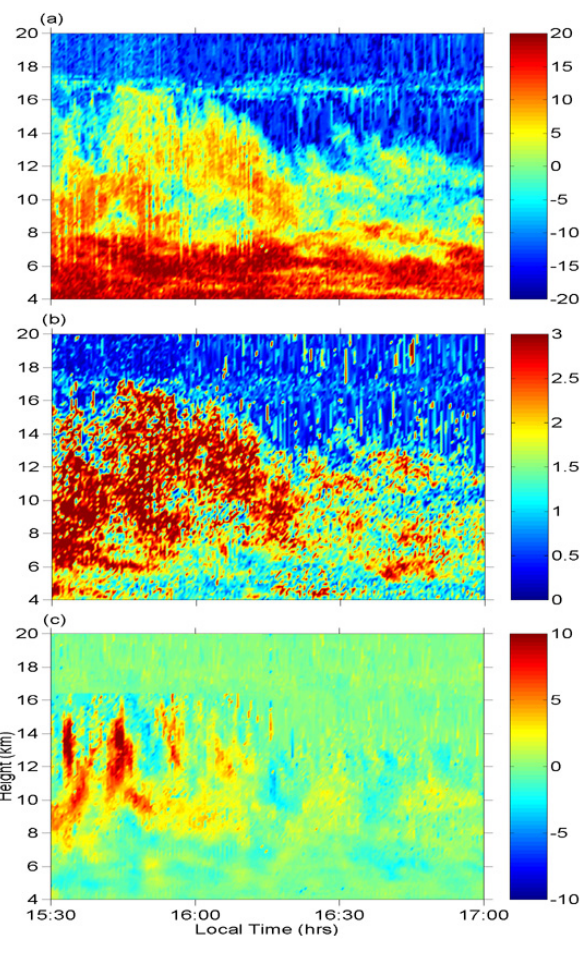
Fig. 7. Height-time sections of (a) VHF radar signal-to-noise ratio (dB), (b) spectral width (m/s) and (c) vertical velocity(m/s) for a multi cell convective system, as observed on 15 September 2001.